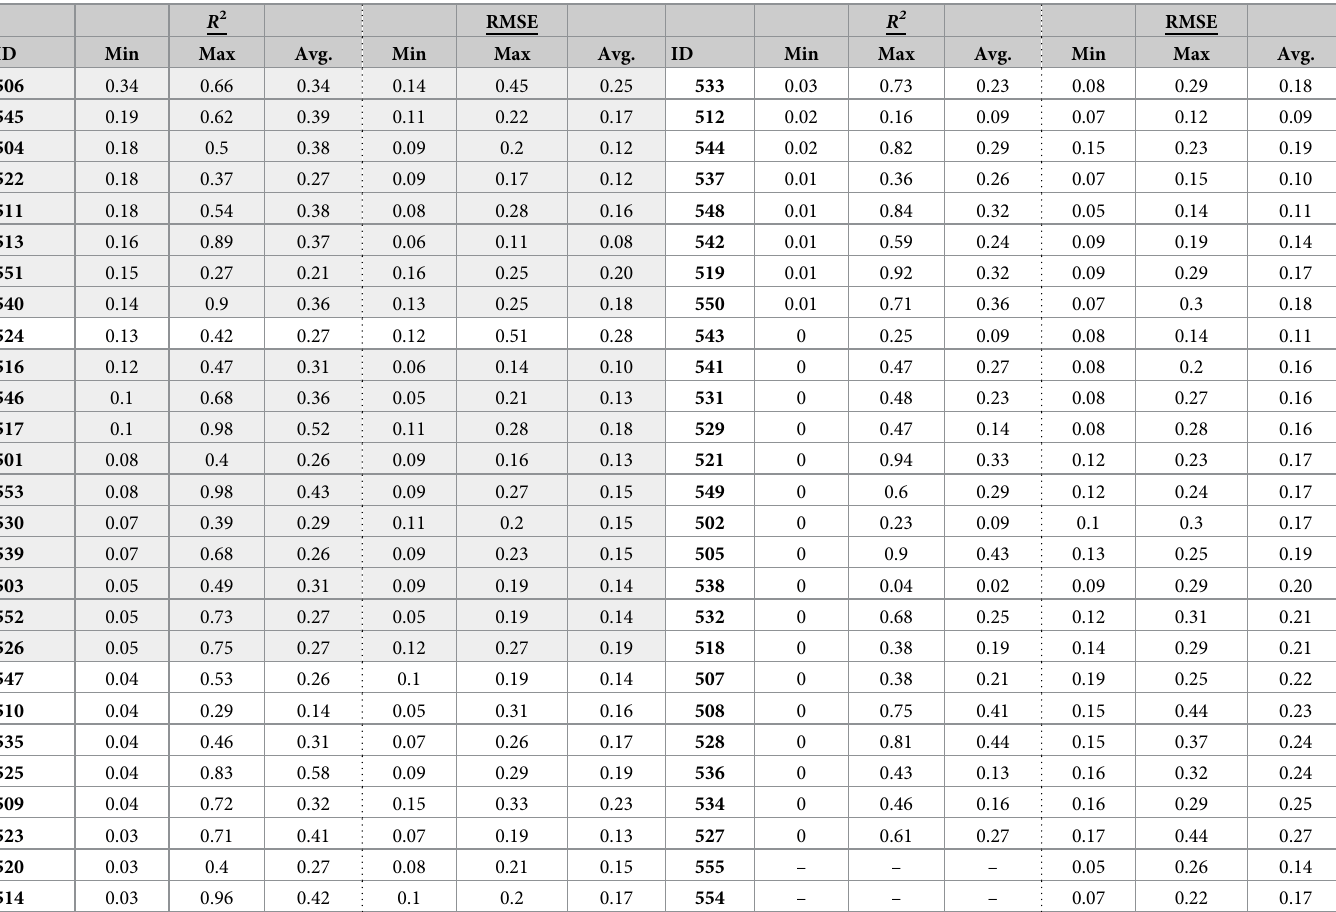
Table 3. Overall, in-fold cross-validated performance across five factor predictive